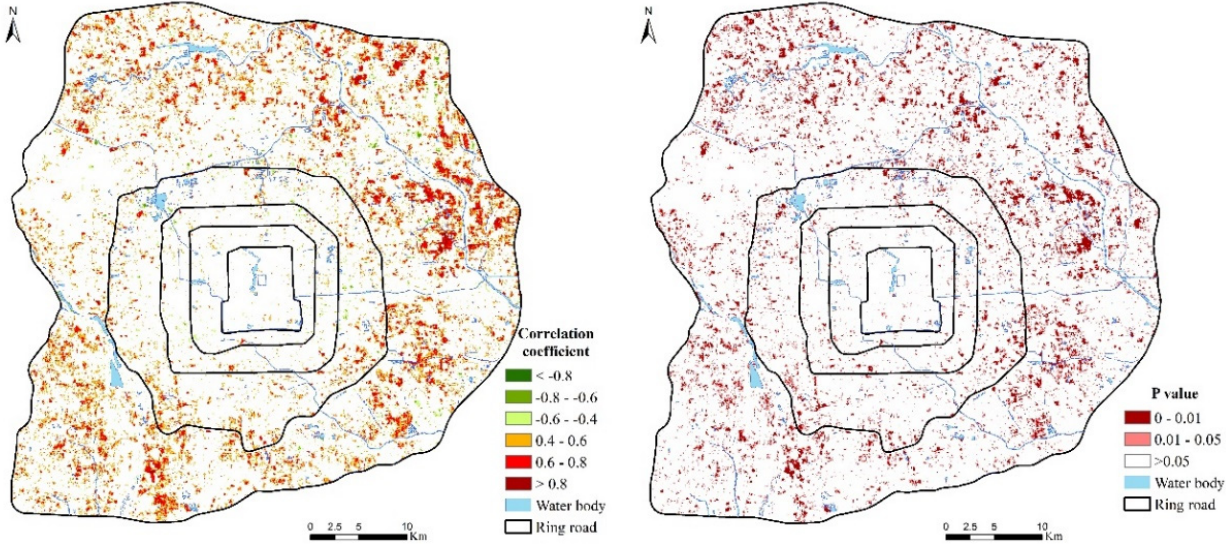
Figure 13. Spatial distribution of Spearman rank correlation coefficient and p value between LST R and population density ( p < 0.05).